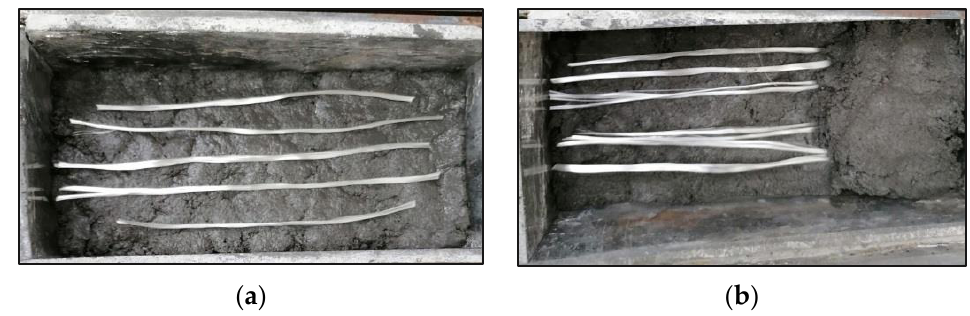
Figure 6. Reinforcement of geopolymers with long fibers: ( a ) method of placement; ( b ) application of the remainder of the geopolymer mixture to the reinforcement.